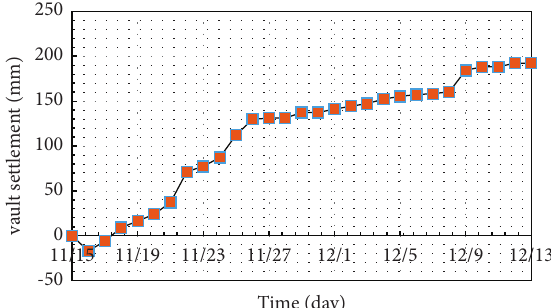
Figure 17: Vault settlement variation of Karst cave area with being